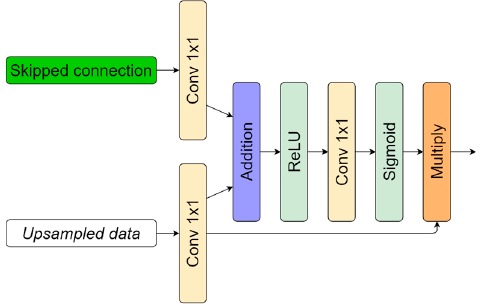
Figure 7. Attention block representation. Upsampled data input taken from the decoder part shown in Figure 2, decoding layer representation before concatenation.